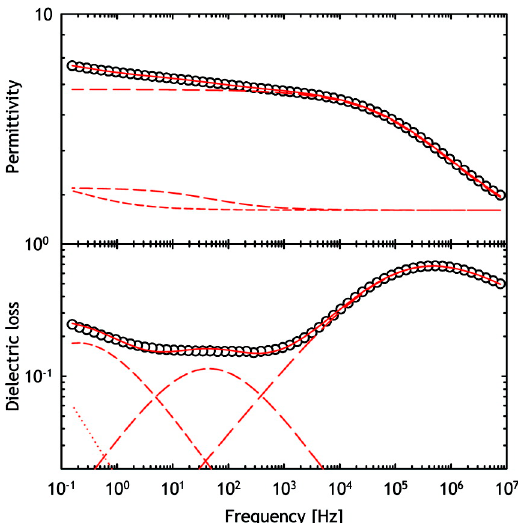
Figure 12. Typical dielectric relaxation spectroscopy (DRS) spectra of lyophilized horse myoglobin powder. Real part (permittivity) and imaginary part (dielectric loss) are presented. Reproduced with permission from [140], ACS, 2009.